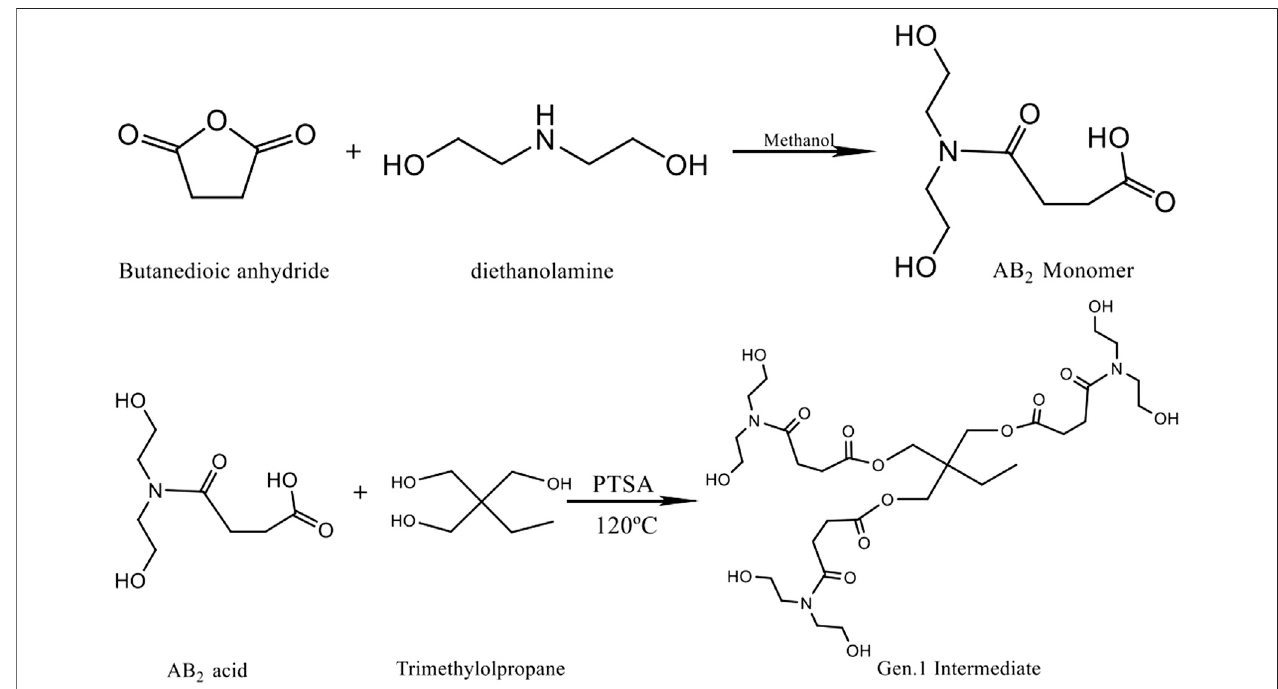
FIGURE 1 | Synthesis of the AB 2 monomer and Gen. 1